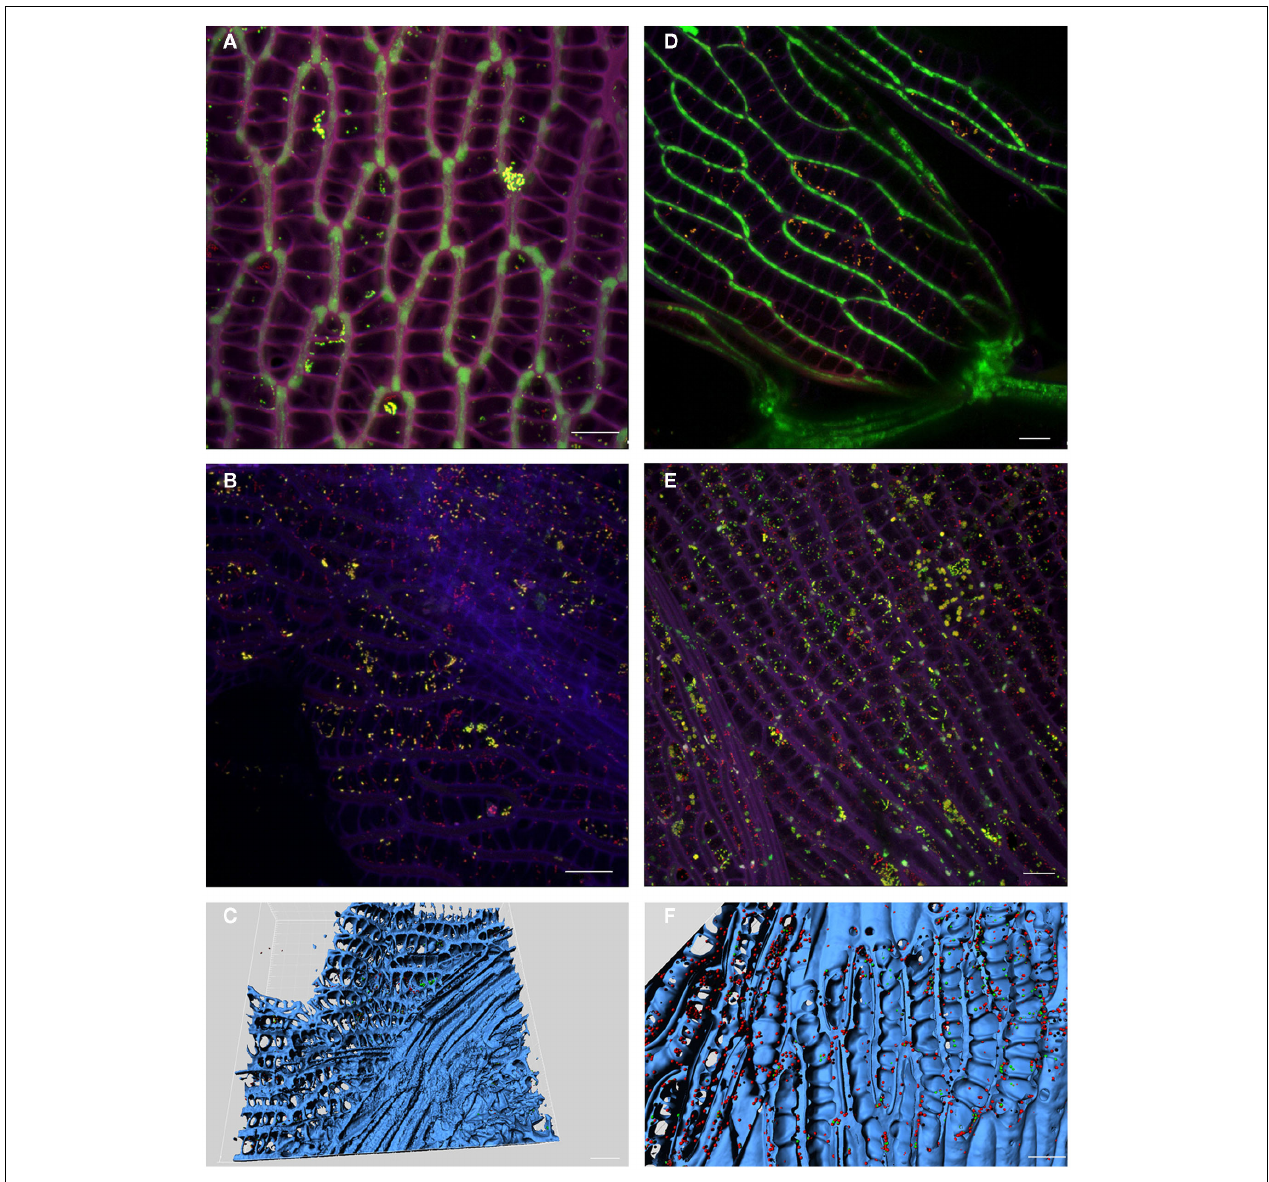
Sphagnum cells; green – chlorophyll-containing Sphagnum chlorocytes; yellow – Alphaproteobacteria; red – other bacteria. 3D computer reconstructions of CLSM images using Imaris7.0 (C,F) : blue – moss tissue; red: Alphaproteobacteria; green: other bacteria. Scale bar = 20 μ